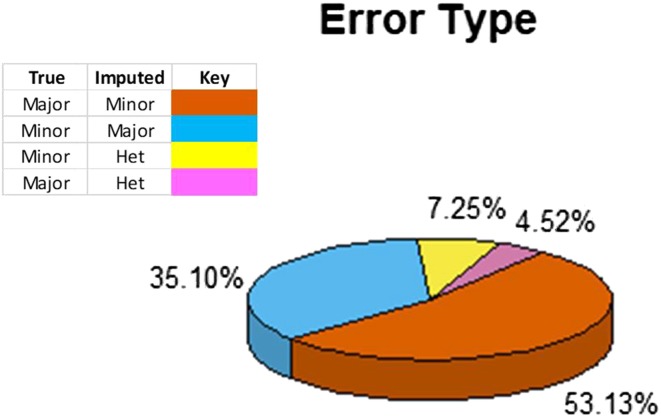
Proportion of errors made as categorized by whether the minor/major/heterozygous alleles was misimputed. In over half of all the errors made, Beagle overimputes the minor allele when the major allele is the true genotype. Incorrect heterozygous imputations make up a minor proportion of the total error and would likely be filtered out in inbred panels.